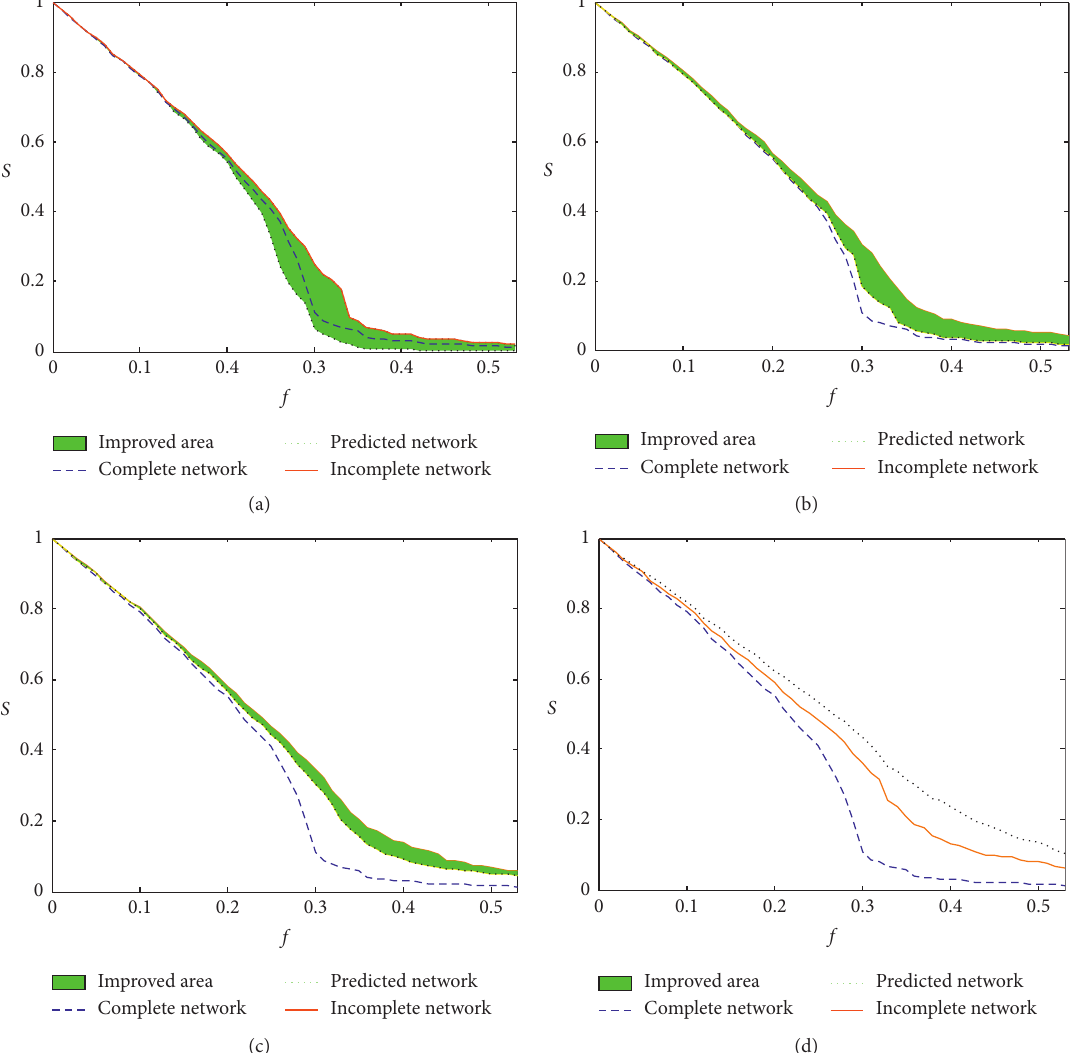
Figure 6: Size of the giant component versus the proportion of attacked nodes with regard to the incomplete, complete, and predicted networks. (a) α � 0.1. (b) α � 0.3. (c) α � 0.5. (d) α �